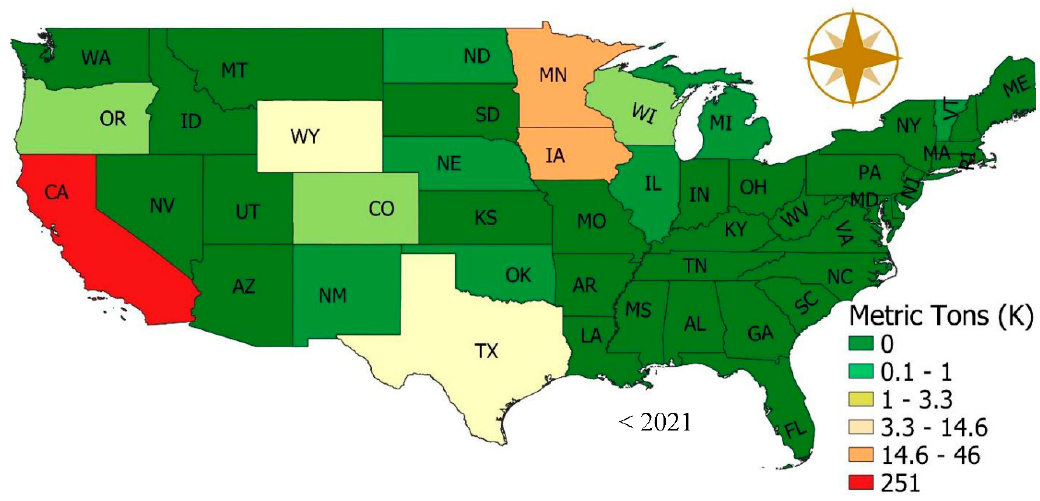
Figure 7. US map showcasing wind turbine mass inventory per state up to 2021.